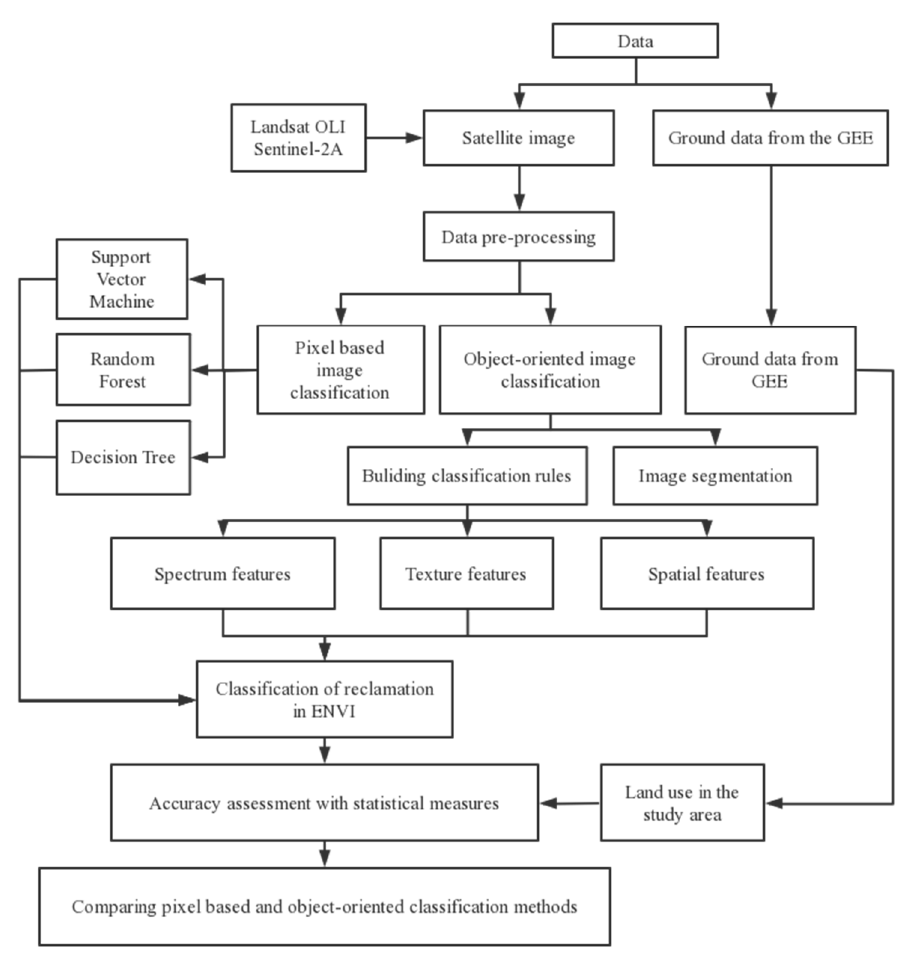
Figure 2. Flowchart of the methodology.